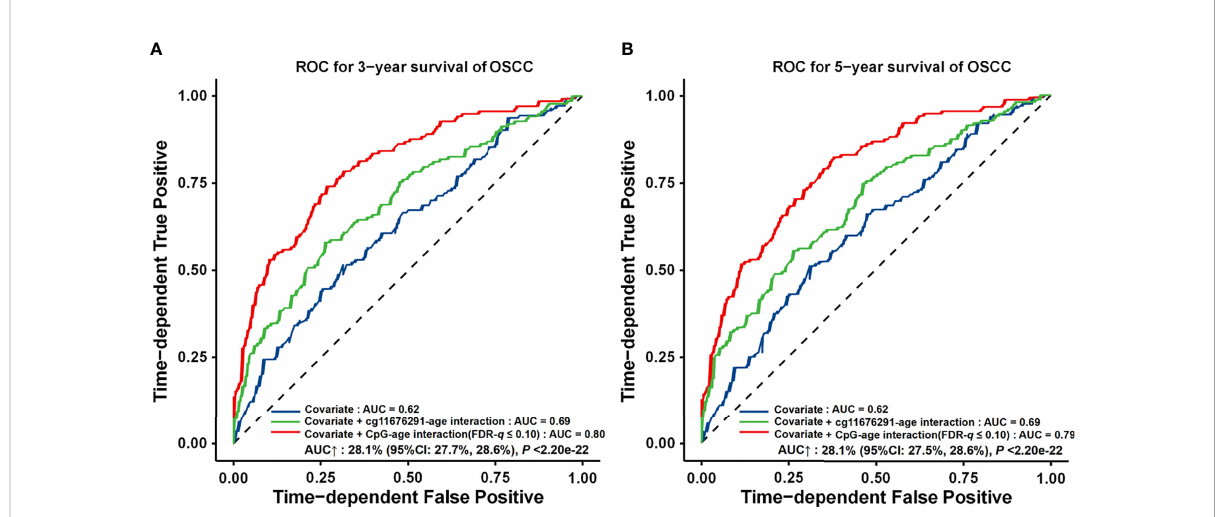
FIGURE 6 ROC curves for different prognostic prediction models using clinical information, gene – age interactions with FDR ‐ q ≤ 0.05 or FDR ‐ q ≤ 0.10. (A) Three ‐ year survival prediction. (B) Five ‐ year survival prediction. The AUC increase (%) was evaluated by comparing the model with gene – age interactions and the model with only the covariates. p-values and 95% CIs were calculated by using 1,000 bootstrap samples and z